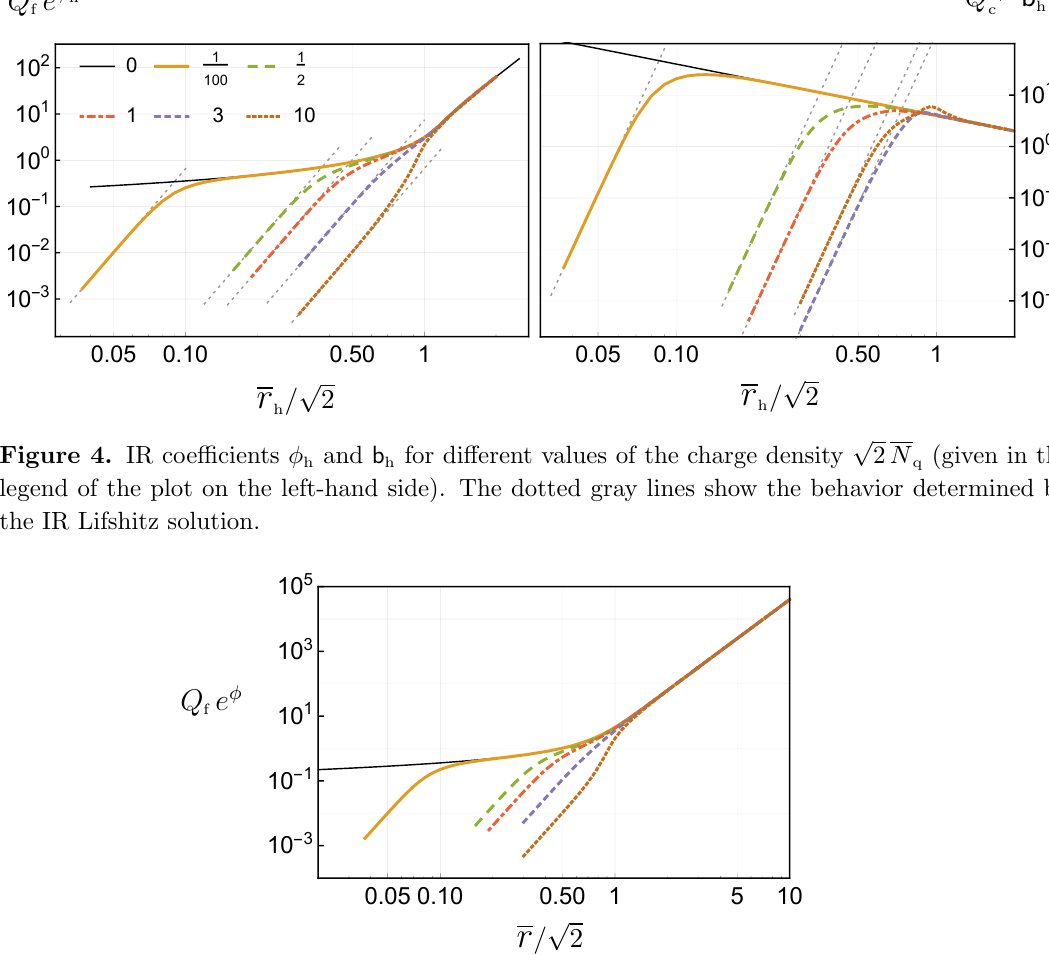
(where the curves h